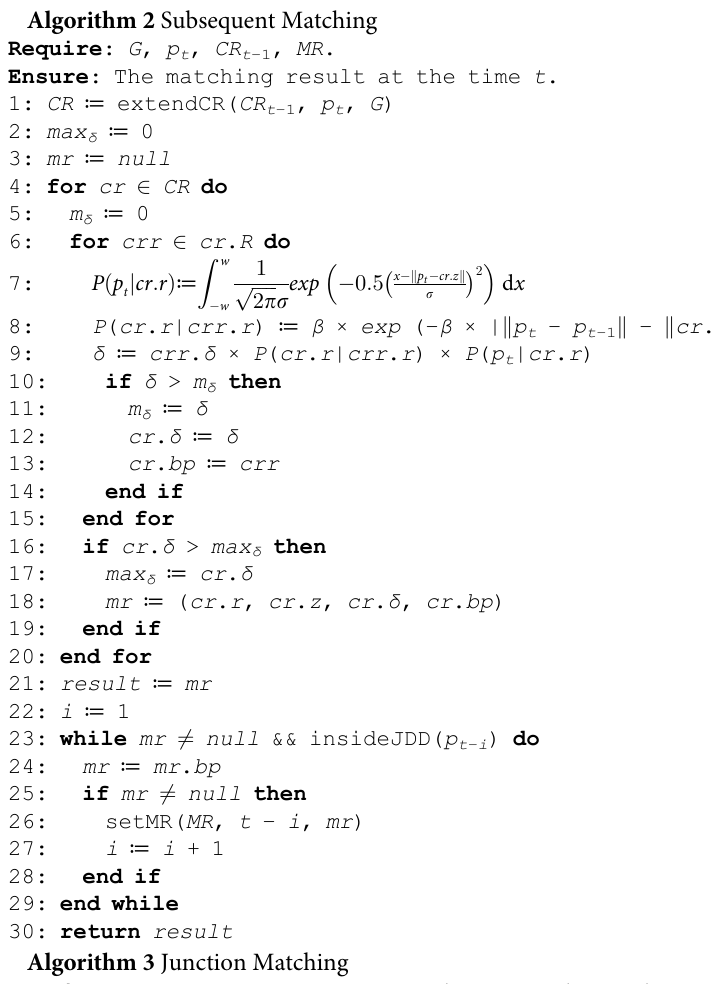
Algorithm 3 Junction